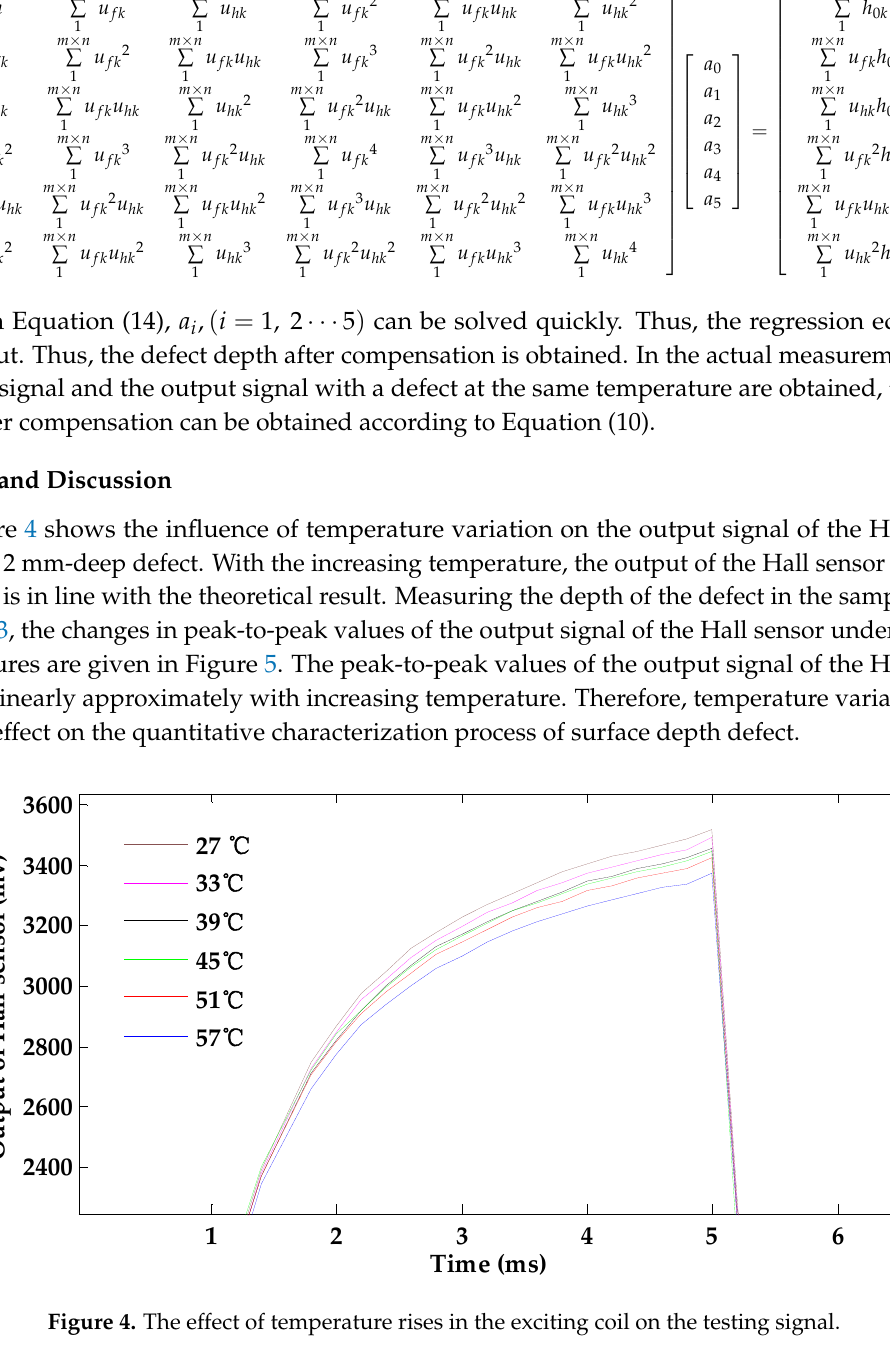
Figure 5. The relationship between the peak-to-peak value of the output signal and the temperature. Figure 6. The relationship between the peak-to-peak value of the output signal and the depth of the defect at different temperatures.